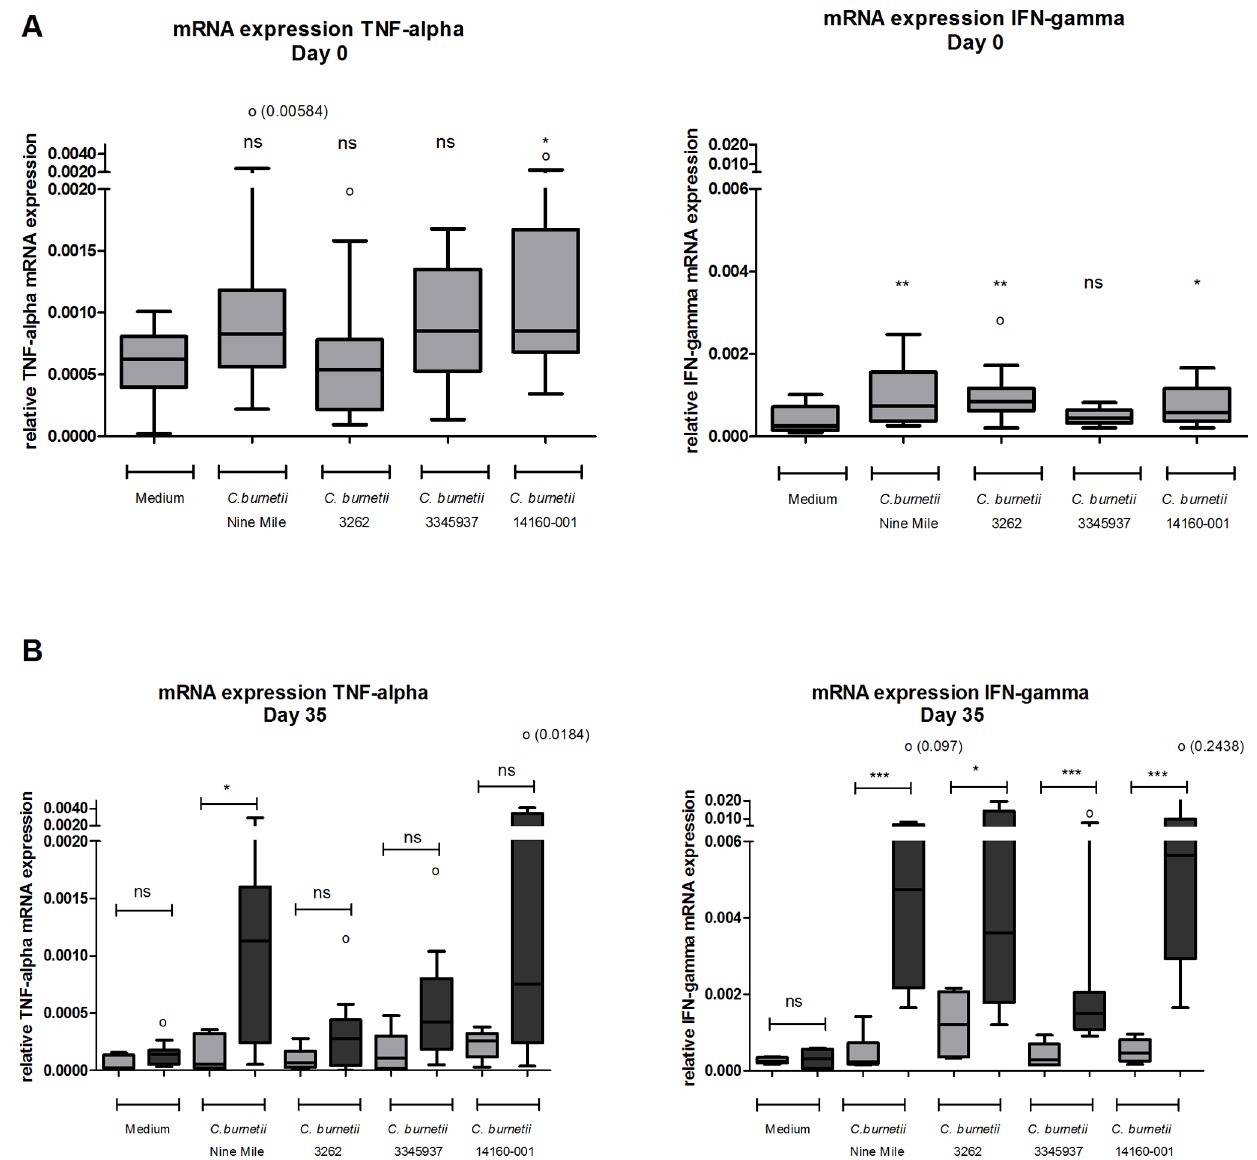
Figure 5. Stimulation of C.burnetii infected PBMCs results in an increased cytokine expression. EDTA blood was sampled at day zero (5A) and day 35 (5B) of the study. Peripheral blood mononuclear cells were isolated and incubated for 4 h or 24 h with either medium, heat killed C. burnetii NM 1 6 10 7 /ml, heat killed C. burnetii 3262 1 6 10 6 /ml, heat killed C. burnetii 3345937 3.2 6 10 4 /ml, heat killed C. burnetii 14160-001 1 6 10 7 /ml. mRNA expression of TNF- a and IFN- c was determined using qPCR. Grey bars represent six naive goats, dark grey bars represent eleven infected goats. Box and Whisker plots are shown. Outliers are indicated as open circles. NS not significant; *p , 0.05; **p , 0.01; ***p , 0.001; ****p , 0.0001, Mann- Whitney U-test.